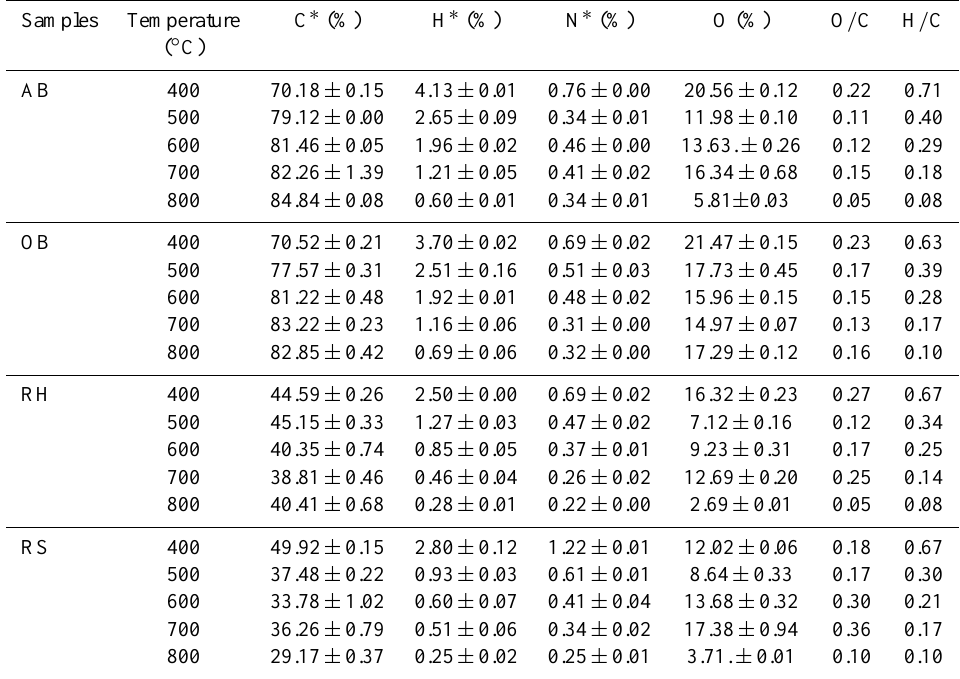
Table 2. Elemental composition of the biochars derived from different feedstocks: apple tree branch (AB), oak tree (OB), rice husk (RH), and rice straw